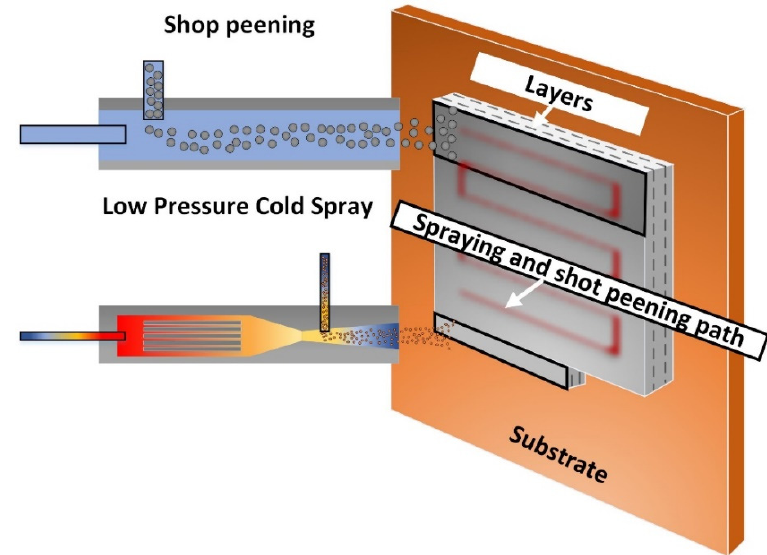
Figure 2. Schematic diagram of SP-LPCS.